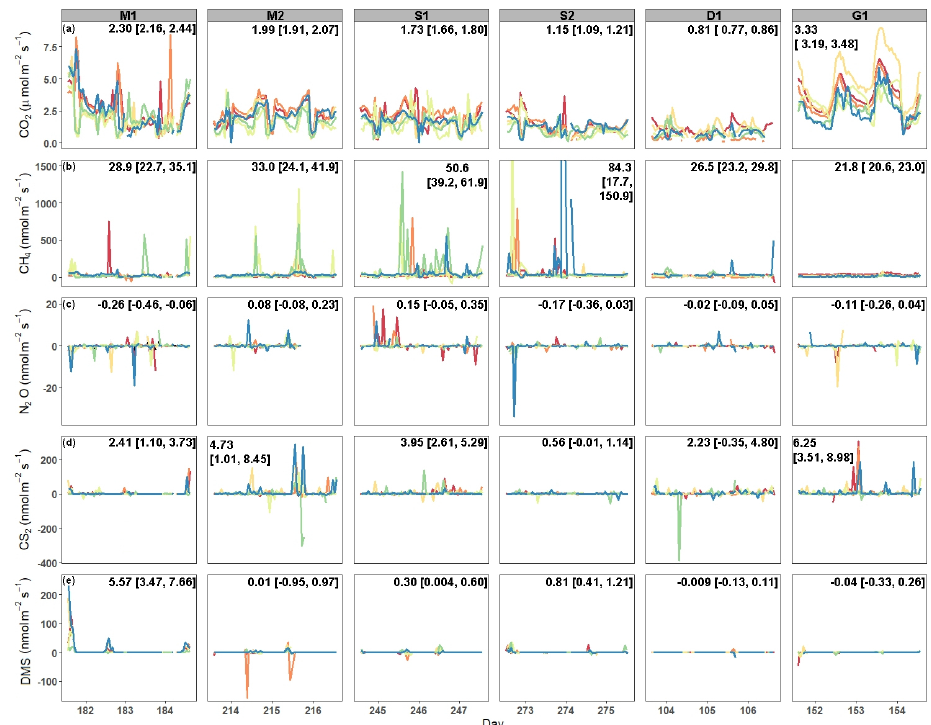
Figure 2. Time series of fluxes from each chamber during each campaign for (a) CO 2 , (b) CH 4 , (c) N 2 O, (d) CS 2 , and (e) DMS. Each color designates a different chamber. The campaign means [LCI = lower 95% confidence interval, UCI = upper 95% confidence interval] are listed on each panel. The y axis for CH 4 fluxes was shortened to show the variability. The full range of CH 4 fluxes during S2 can be seen in Fig. S1 in the